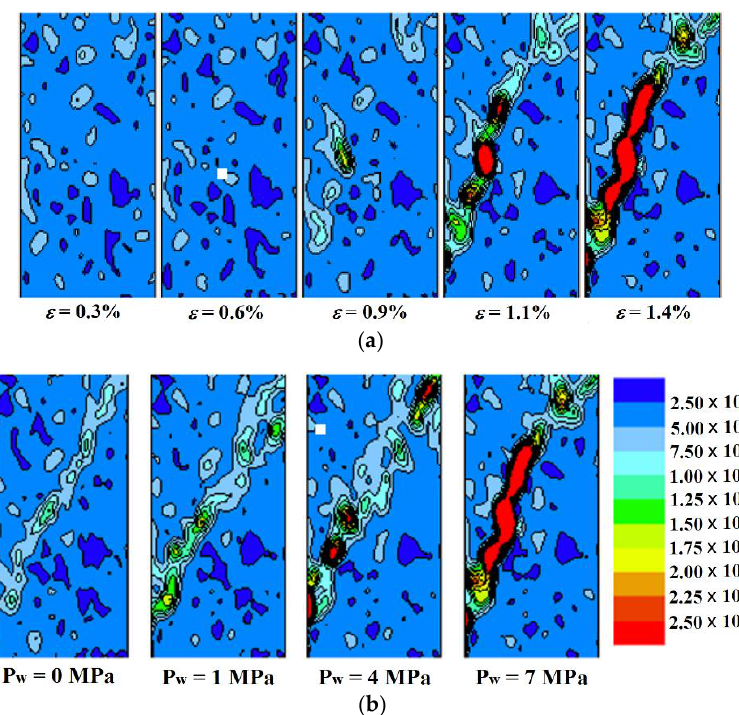
Figure 3. Contour of simulated progressive permeability distribution along with stress–strain process [37]: ( a ) under maintained pore pressure 7 MPa; ( b ) eventual peak stress states under various maintained pore pressures.